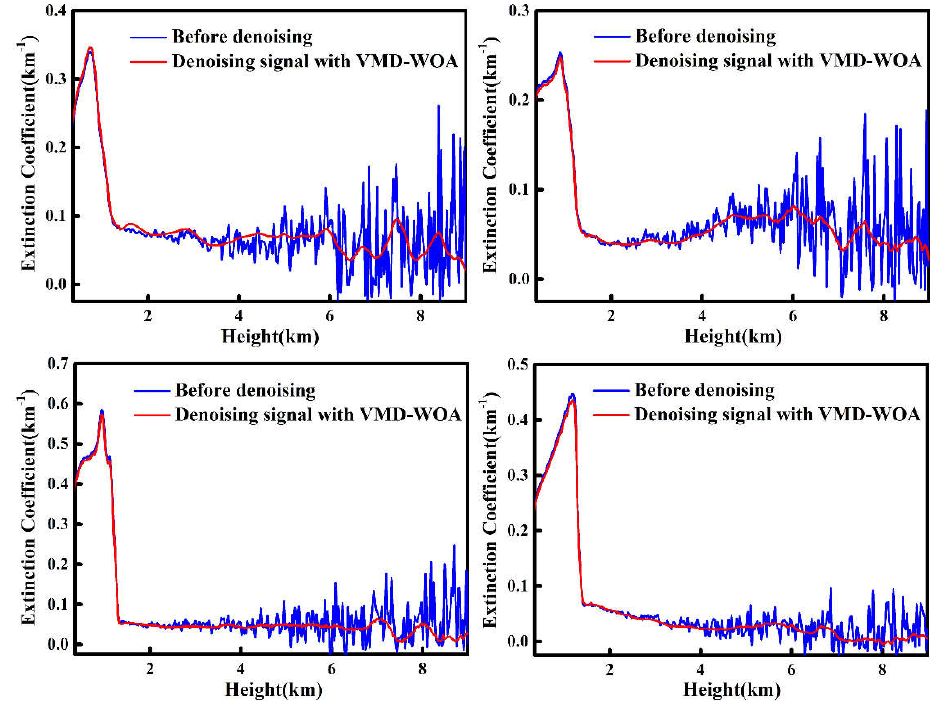
Figure 10. Comparison of aerosol extinction coefficient profiles from different observation times.